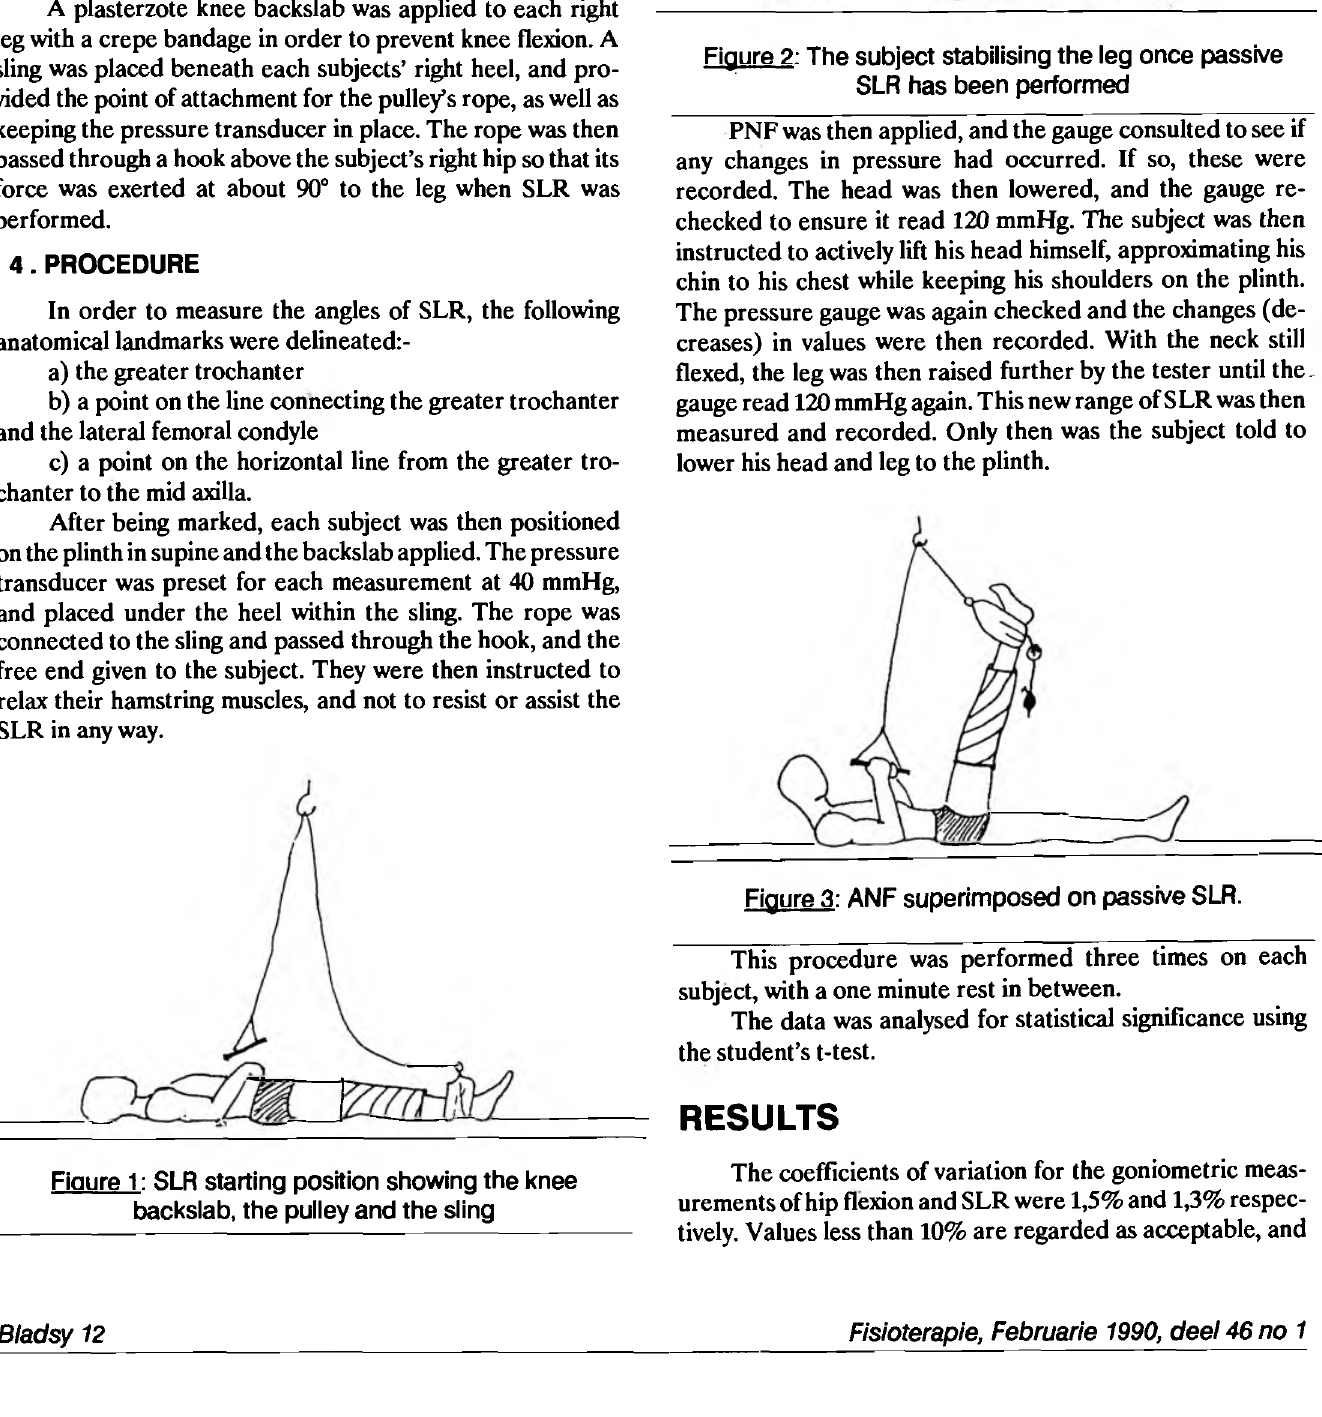
Figure 2: The subject stabilising the leg once passive